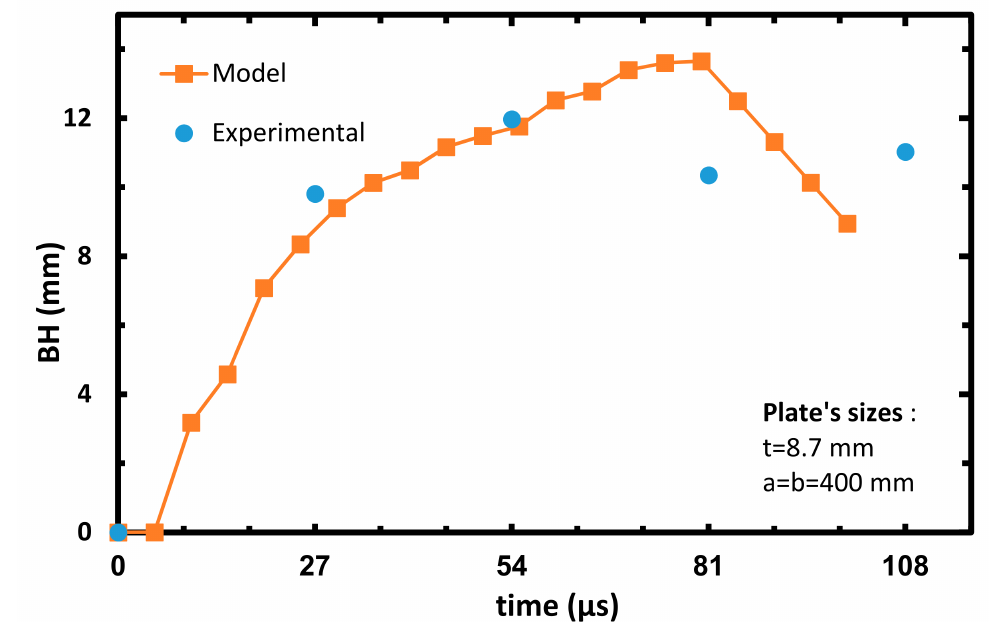
Figure 17. Plate’s bulge height vs. time of the calibrated model, Vinitial = 698